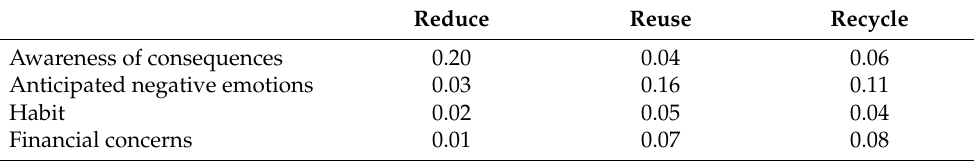
Table 6. Effect Size (f 2 ).